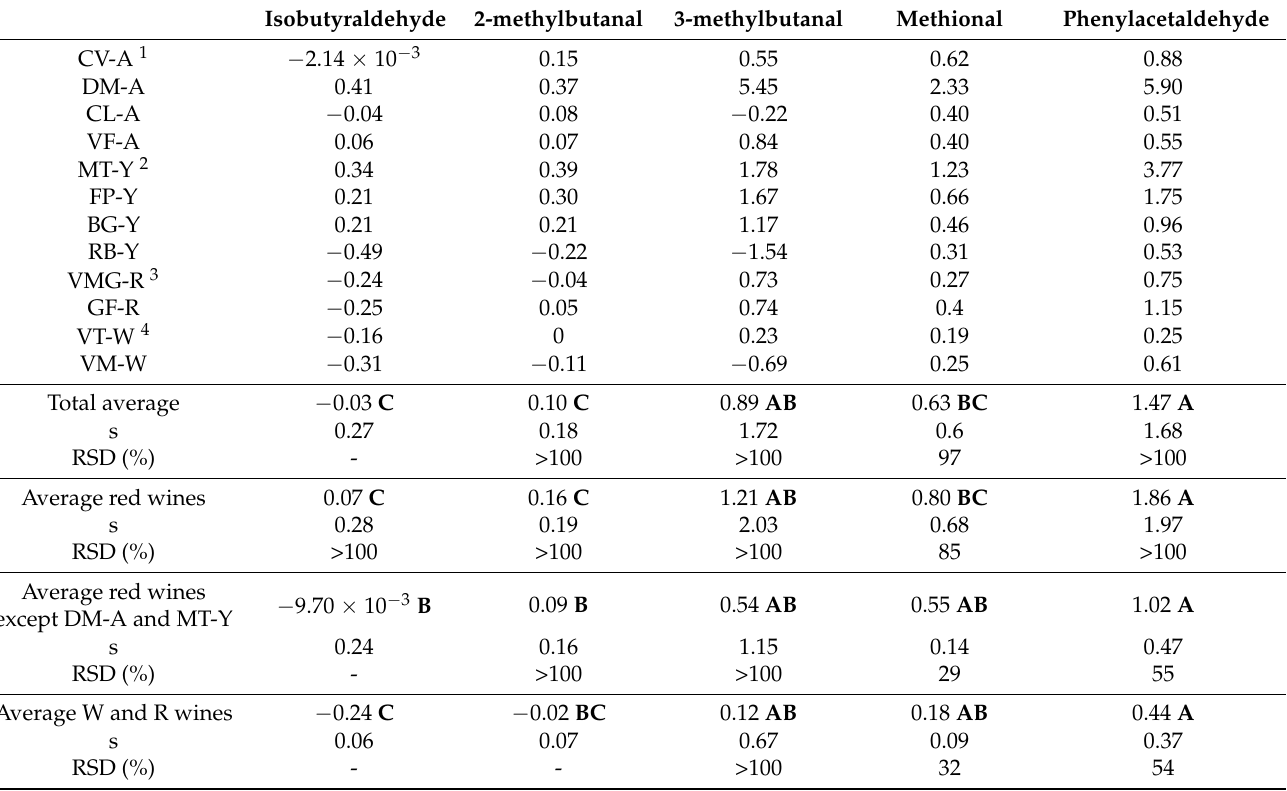
Table 3. Accumulation rates ( µ g/L/day) of Strecker aldehydes in the 12 wines after the oxidation process, considering the days of oxidation (23.9–51.8 days). Average, deviation and RSD (%) of the whole group and of reds, reds without the wines that have pH 3.8 and W and R wines: whites and ros é s. The results of the analysis of variance ANOVA ( p = 0.05) are shown in capital letters. Different letters indicate significant